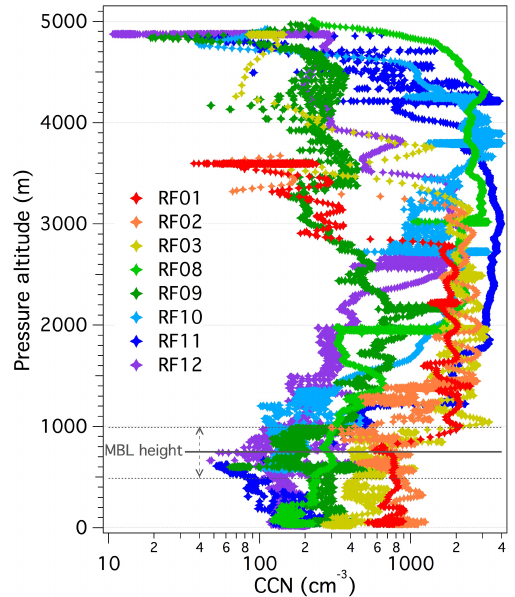
Figure 2. Vertical profiles (altitude in meters) of CCN concentration (cm − 3 ) from 0.1 to 0.4% supersaturation for all flights in this